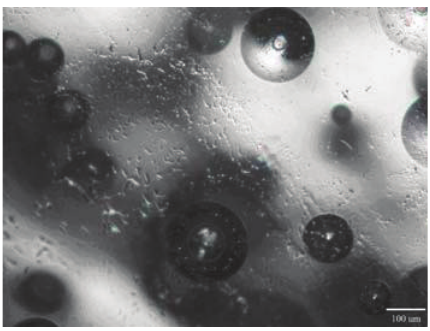
Figure 14: Embedded microvoids